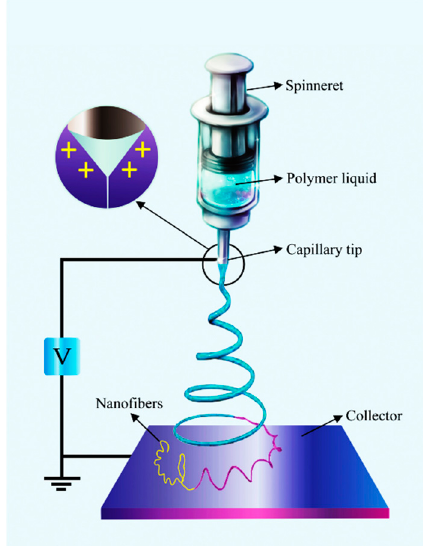
Figure 1. A schematic of the single-spinneret electrospinning (Reproduced with permission from [62]. Royal Society of Chemistry, 2017).